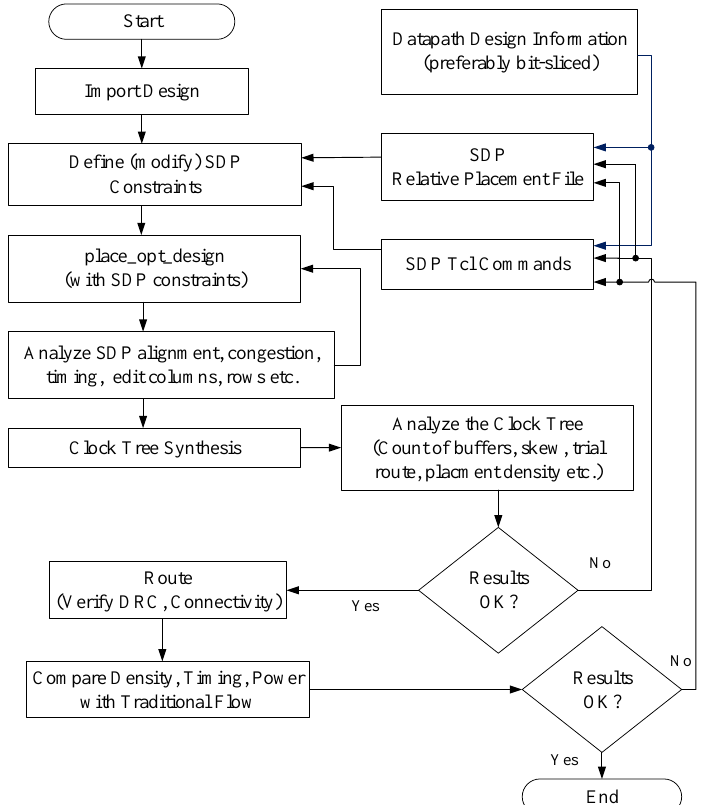
Figure 4. SDP-based Standard Cell Design Flow.